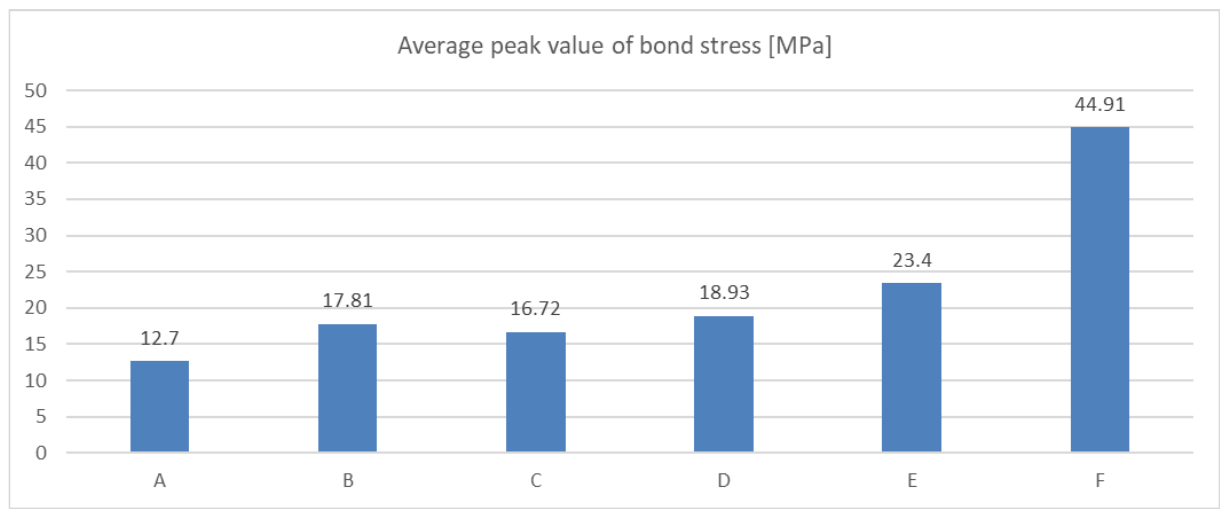
Figure 21. Comparison of bond strength of selected adhesive types: (A) — Average value of large number of adhesives [39], (B) — Hilti-HVU-C20/25 [38], (C) — Hilti-R150-C20/25 [38], (D) — Hilti-RE500-C20/25 [38], (E) — Hilti-RE500-C40/45 [38],